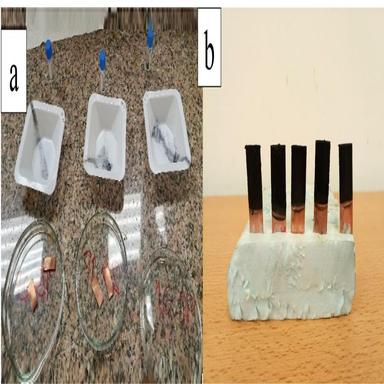
Copper sheet (a) after degreasing and (b) coated copper sheet with electrode material.